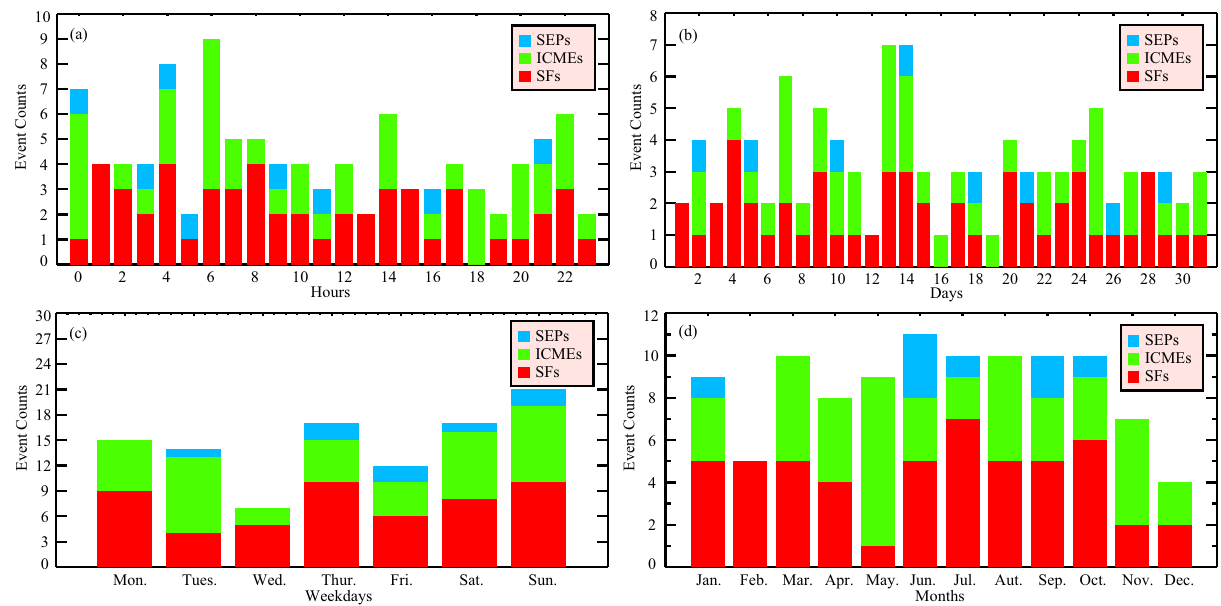
Figure 1. The distributions of SWEs in hours, days, weekdays and months from 2015 to